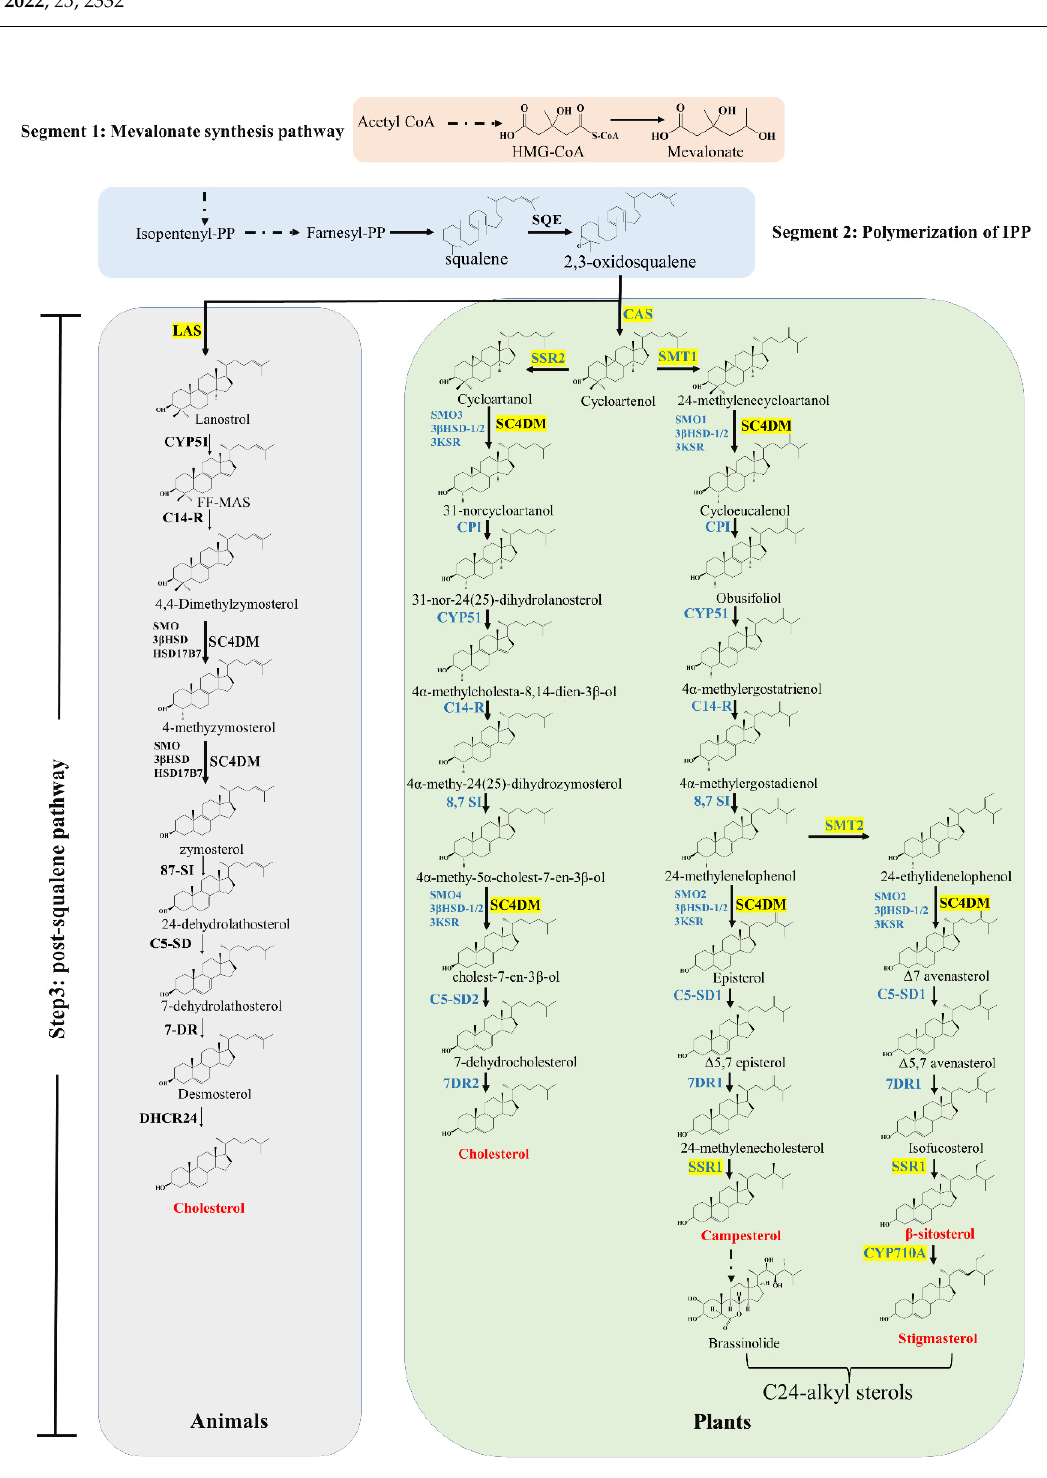
Figure 2. Biosynthesis pathways of plant sterols. Enzymes of the plant sterols synthesis pathway are marked in blue, the key enzymes that regulate C24-alkyl sterol synthesis are depicted in yel- low, major sterols in plants are marked in red, and dotted lines represent multiple reaction steps.